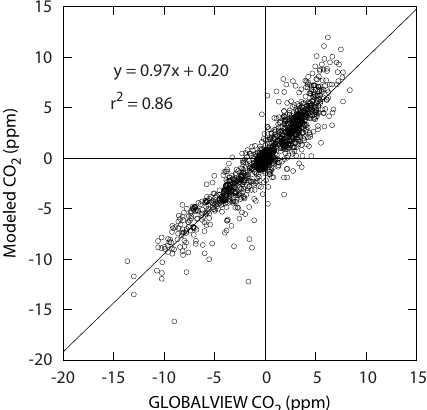
Figure 2. Comparison of the mean monthly CO 2 variability calcu- lated with GLOBALVIEW and with the model presented